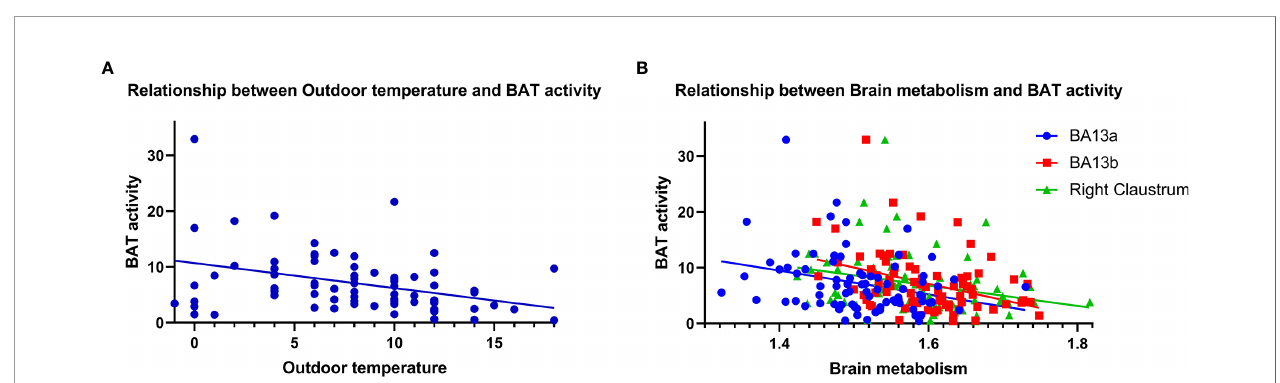
FIGURE 5 | Correlation analysis of brain semi-quantitative metabolism values and average outdoor temperature with BAT activity. BAT activity was negatively correlated with average outdoor temperature [ (A) , r = -0.366, P = 0.001] and semi-quantitative values of brain metabolism. [ (B) , BA13a r = -0.293, P = 0.008; BA13b r = -0.374, P = 0.001; right claustrum r = -0.279, P =